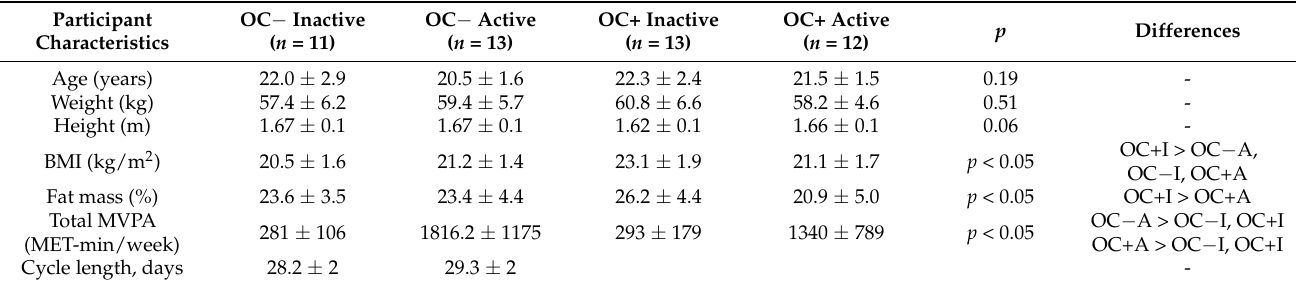
Table 1. Participant